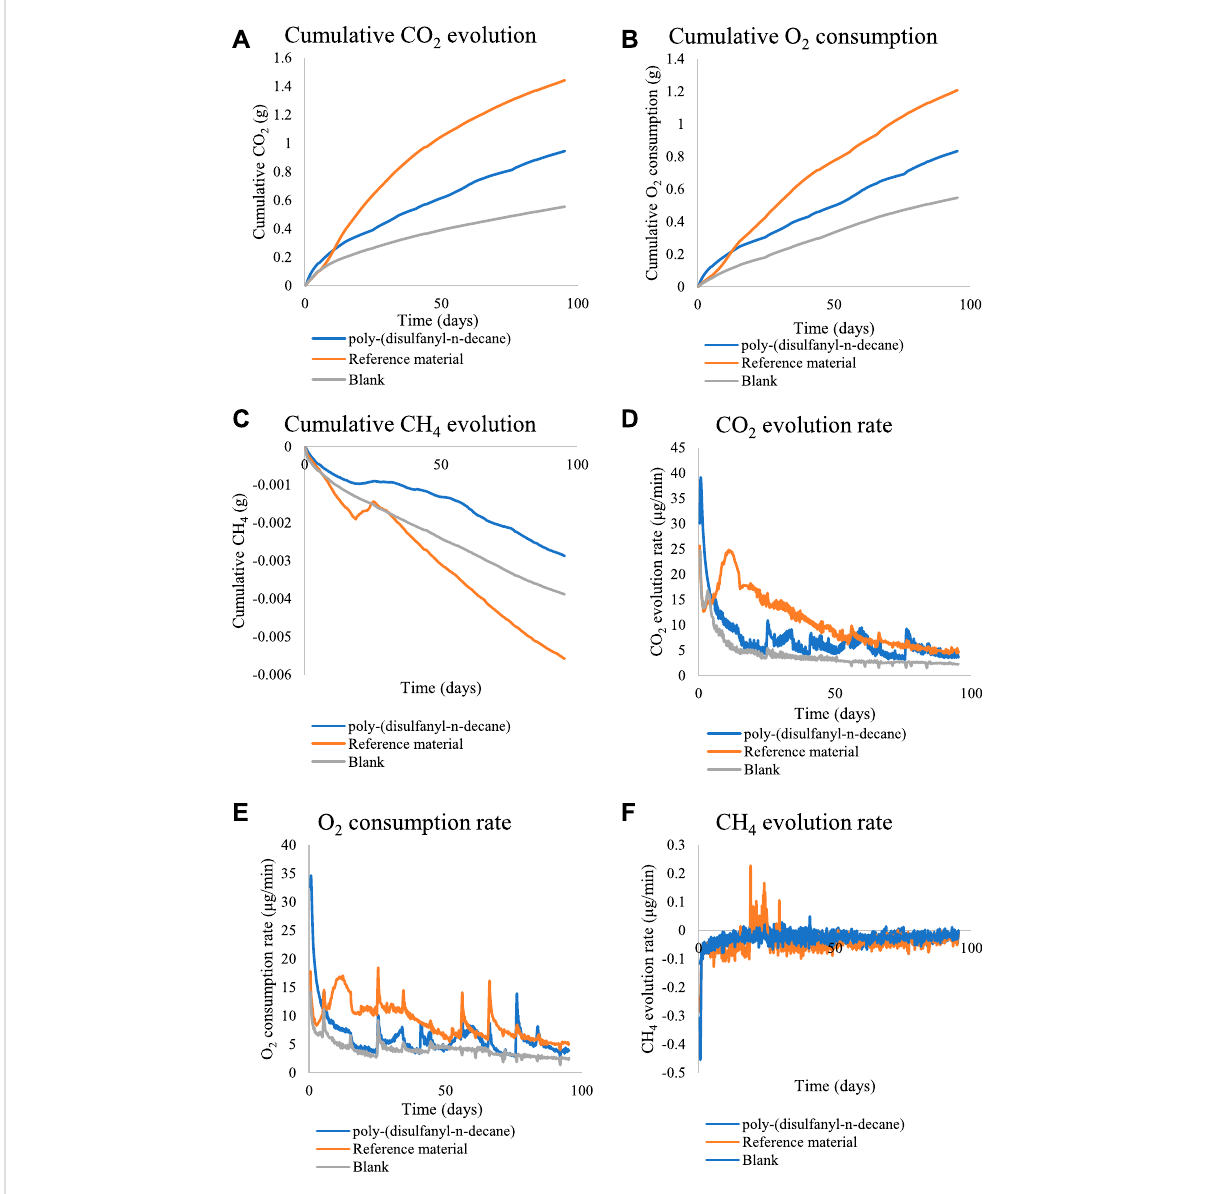
FIGURE 5 The cumulative amounts and rate of CO 2 , O 2 and CH 4 for the biodegradability test of poly-(disulfanyl-n-decane). (A) The cumulative CO 2 evolution. (B) The cumulative O 2 consumption. (C) The cumulative CH 4 evolution. (D) The CO 2 evolution rate. (E) The O 2 consumption rate. (F) The CH 4 evolution